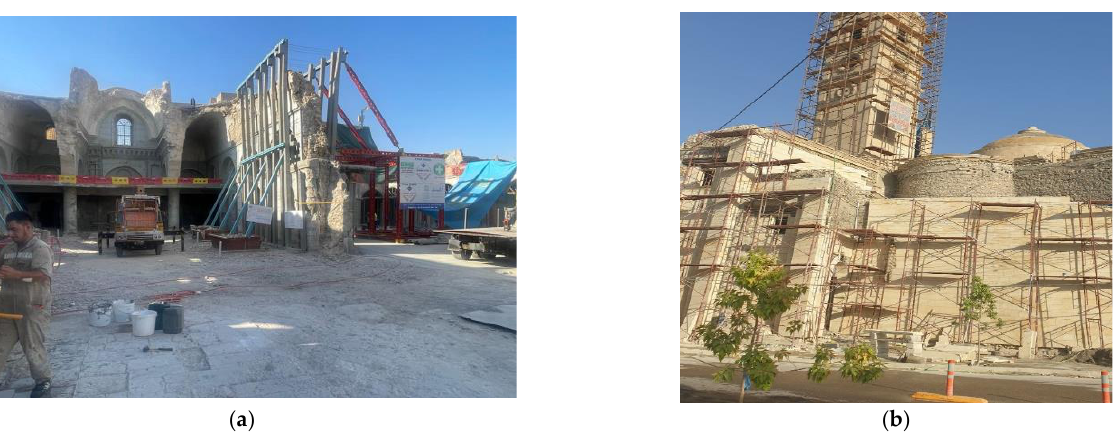
Figure 5. The destruction of the Nabi Yunus SHRINE https://www.thesun.co.uk/news/2728270/nabi-yunus-shrine-mosul-isis/, accessed on 20 June 2022. Credit: Reuters [25].